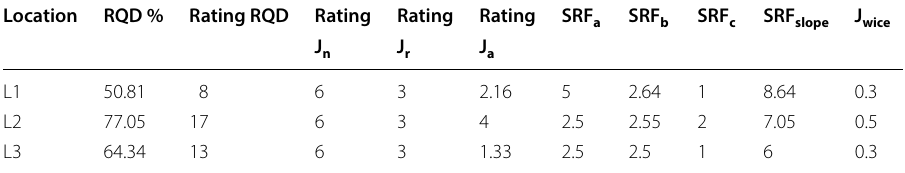
parameters for all locations slope